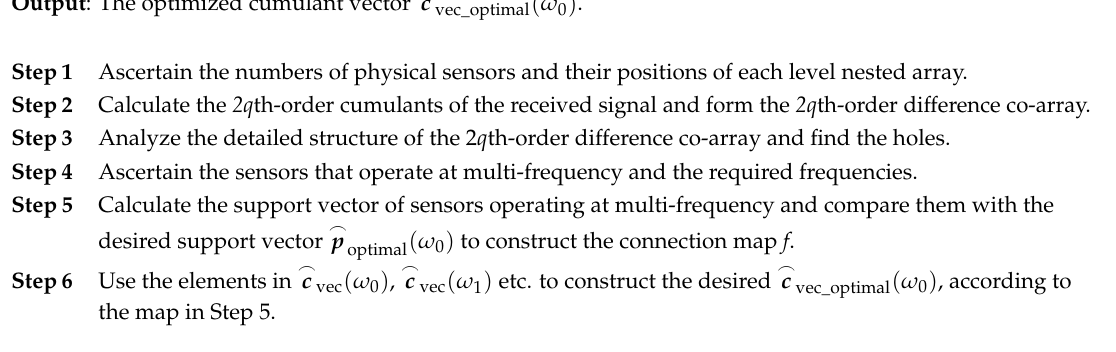
Algorithm 1. Summary of the Multi-Frequency Method for Minimum Frequency Separation